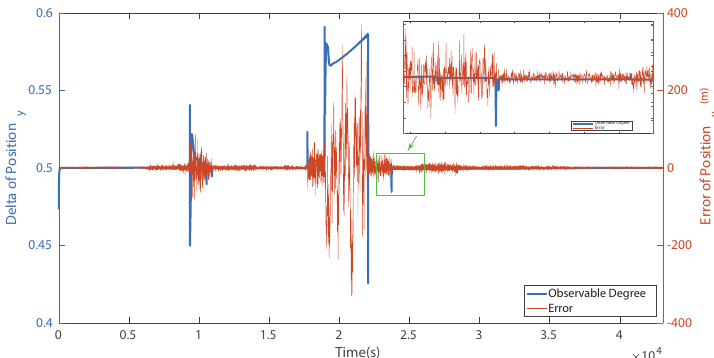
Figure 9. This is a comparison chart between error and observable degree at portion